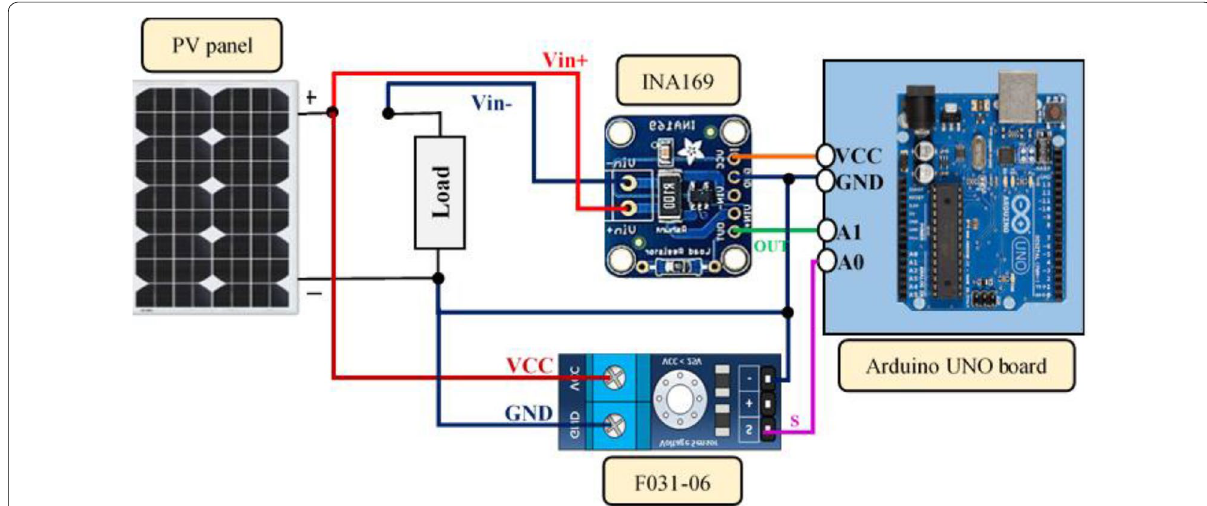
Fig. 10 Schematic view of the hardware components connected to the Arduino UNO